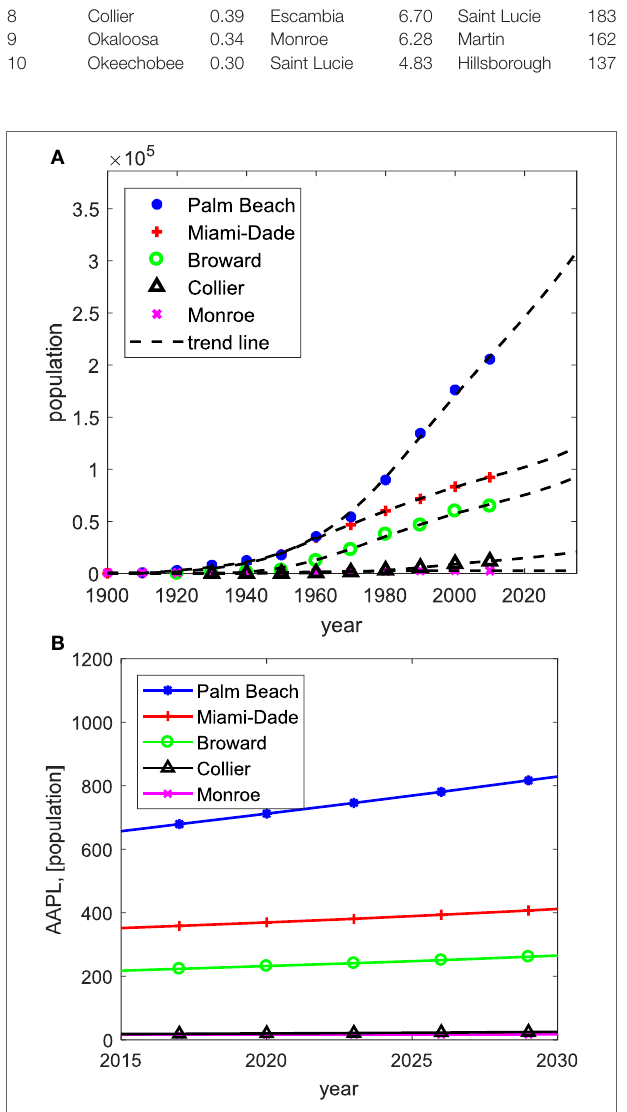
FigUre 9 | Predicted changes of: (a) population in Florida between 1990 and 2030, (B) the AAPL between 2015 and